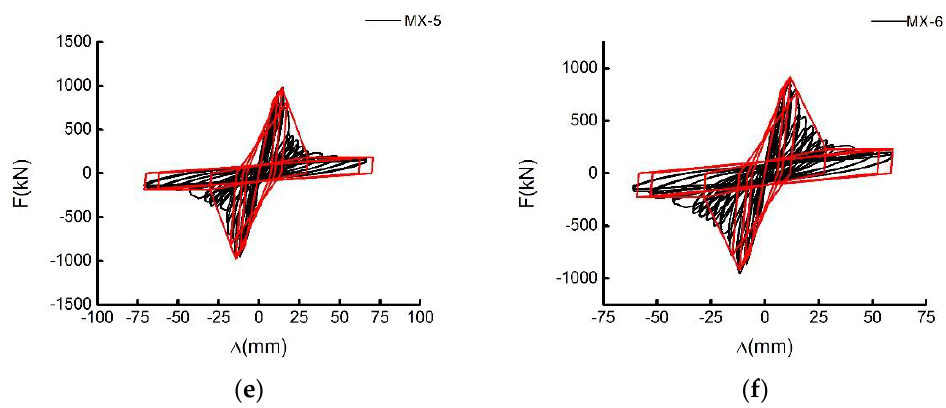
Figure 12. Restoring force model of each specimen: ( a ) MX-1; ( b ) MX-2; ( c ) MX-3; ( d ) MX-4; ( e ) MX-5; ( f ) MX-6.